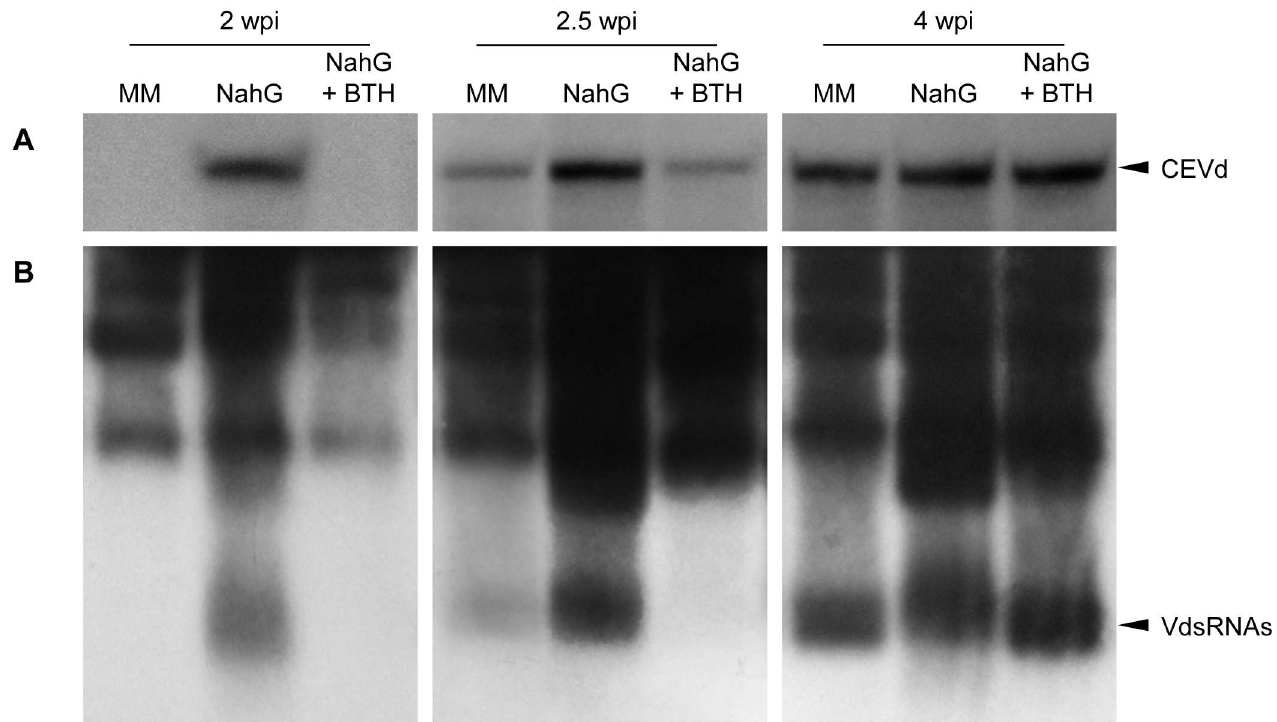
Fig 7. Detection of CEVd levels in infected Money Maker, NahG and BTH-treated NahG plants. PanelsA and B show the Northern blot analysesto detect Citrus Exocortis Viroid (CEVd) and CEVd-specific small RNAs (VdsRNAs), respectively, at 2, 2.5 and 4 weeks after inoculation (wpi). RNAs were separated in a 5% or 17% denaturingpolyacrylamide gel, then transferred and hybridized with radioactivenegativestrand CEVd riboprobes. CEVd and its corresponding small RNAs are denotedwith an arrow.